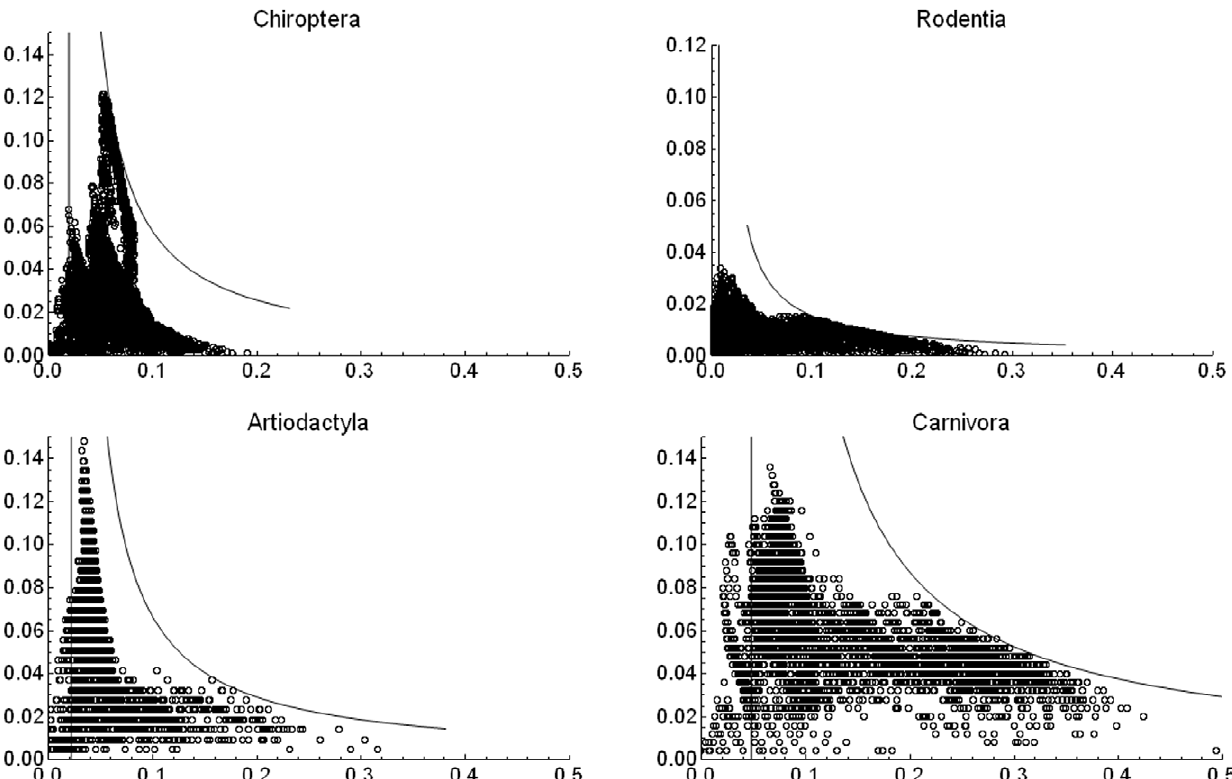
Figure 4. Range-diversity plot for different taxonomic groups. Boundary lines as in figure (2), with parameters: Chiroptera (cid:2) tt =4.6 6 10 2 3 , b W =51.27; Rodentia (cid:2) tt 1.4 6 10 2 3 , b W =138.95; Artiodactyla (cid:2) tt = 5.2 6 10 2 3 , b W =45.77; Carnivora (cid:2) tt =1.33 6 10 2 2 , b W =20.98. Beta changes because every plot was obtained from a different PAM, extracted from the global